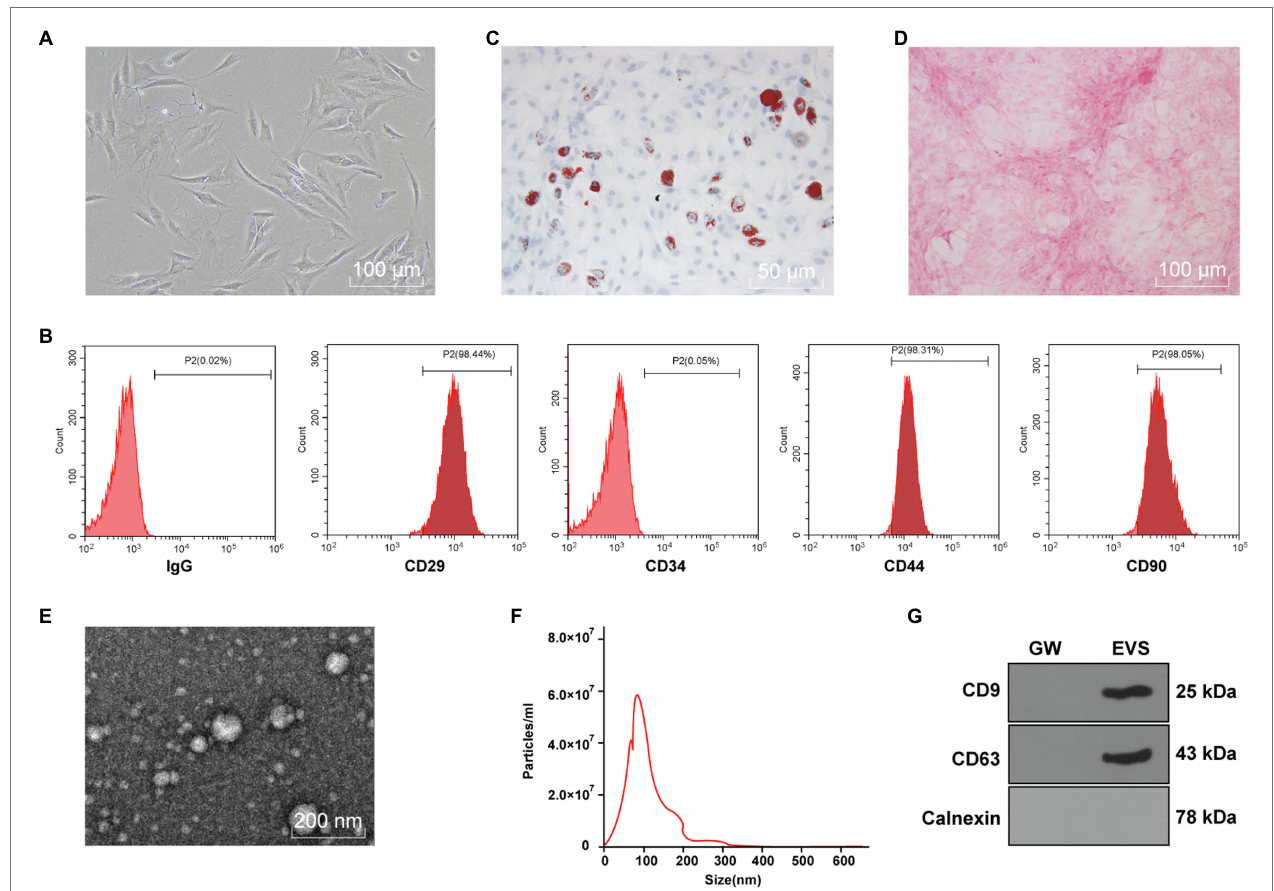
FIGURE 1 | Identification of human bone marrow mesenchymal stromal cells (hBMSCs) and extracellular vesicles (EVs). The purchased hBMSCs were purified. (A) morphology of hBMSCs observed under a microscope; (B) surface antigens in hBMSCs detected by flow cytometry; (C) lipid differentiation observed by Oil red O staining; (D) osteogenic differentiation observed by Alizarin red staining; (E) morphology of EVs isolated from hBMSCs using ultra-high-speed centrifugation observed under transmission electron microscope (TEM); (F) EV size distribution analyzed by nanoparticle tracking analysis (NTA); (G) expressions of CD9, CD63, and Calnexin in EVs detected by Western blot. Cell experiment was repeated three